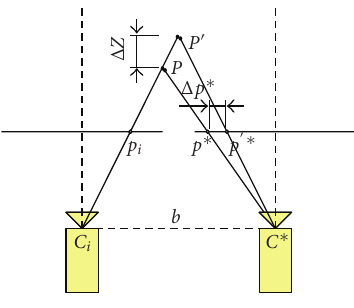
Figure 4: Translation of the